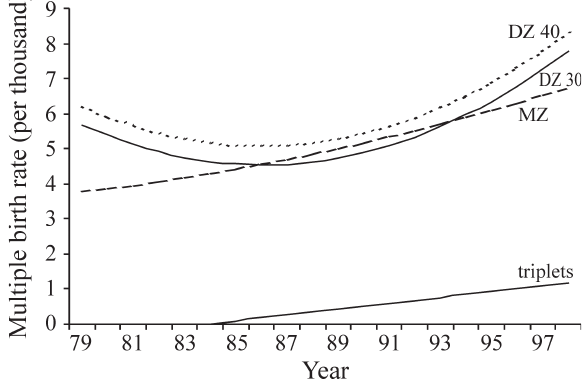
Figure 1 - Best-fit regression curves for the annual distribution rates of monozygotic (MZ) and dizygotic (DZ) twins, and triplets. As dizygotic twin rates are dependent on temporal variation (years) and on maternal age, two curves are shown, for mothers aged 30 (DZ-30) and 40 years (DZ-40). Table 1 - Number of singleton, twin and triplet births from 1979 to 1998. (MM = male/male, FF = female/female, MF = male/female; rates per thousand: DZR = dizygotic twins, MZR = monozygotic twins, TR = total twins and TriR = triplets. Number of